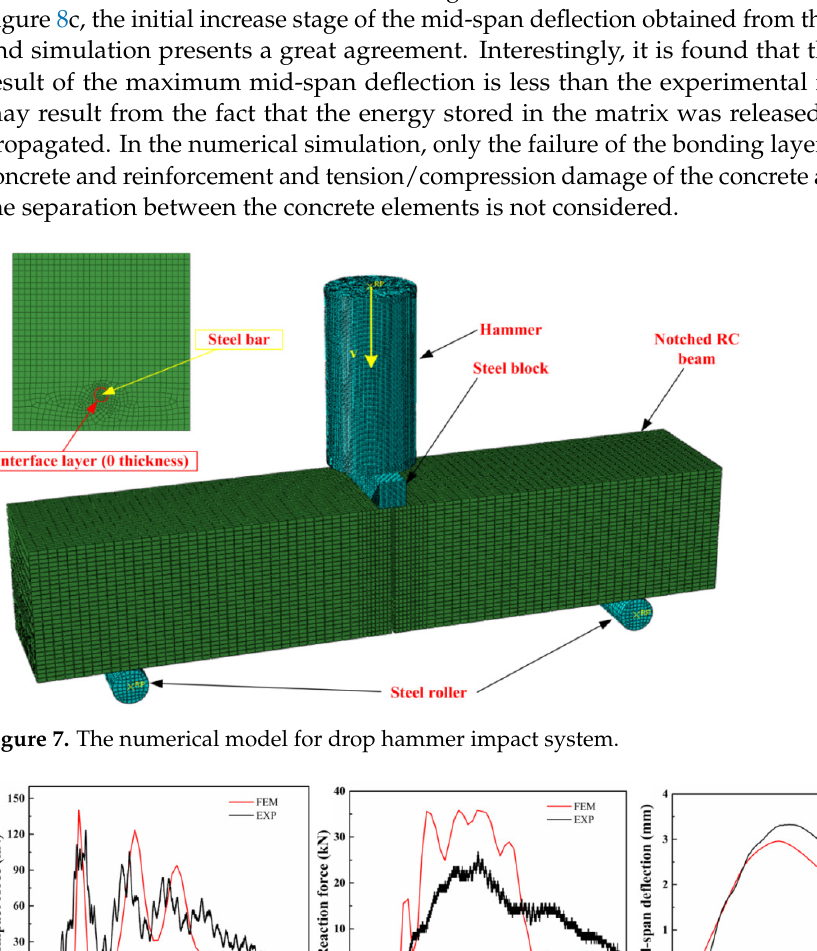
Figure 7. The numerical model for drop hammer impact system.